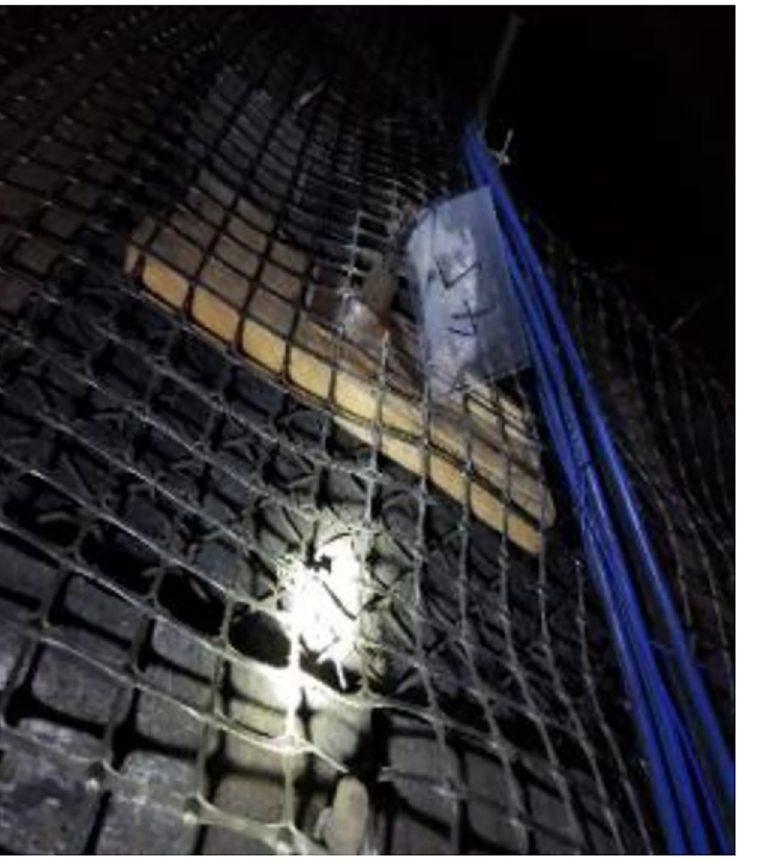
Fig 21. Another of the bolt installation